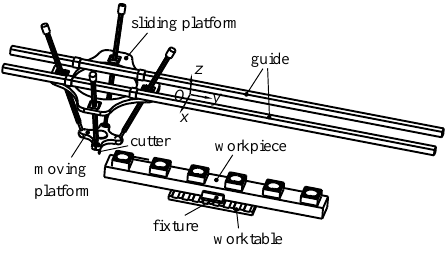
Figure 1: CAD model of the 5-DOF GHMT sliding platform